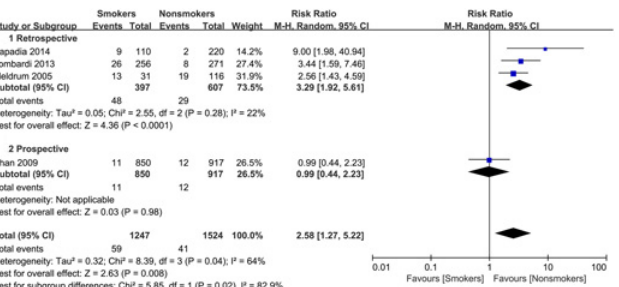
Fig 5. Forest plot of the association between smoking and the risk of all-cause revisions after total hip arthroplasty.